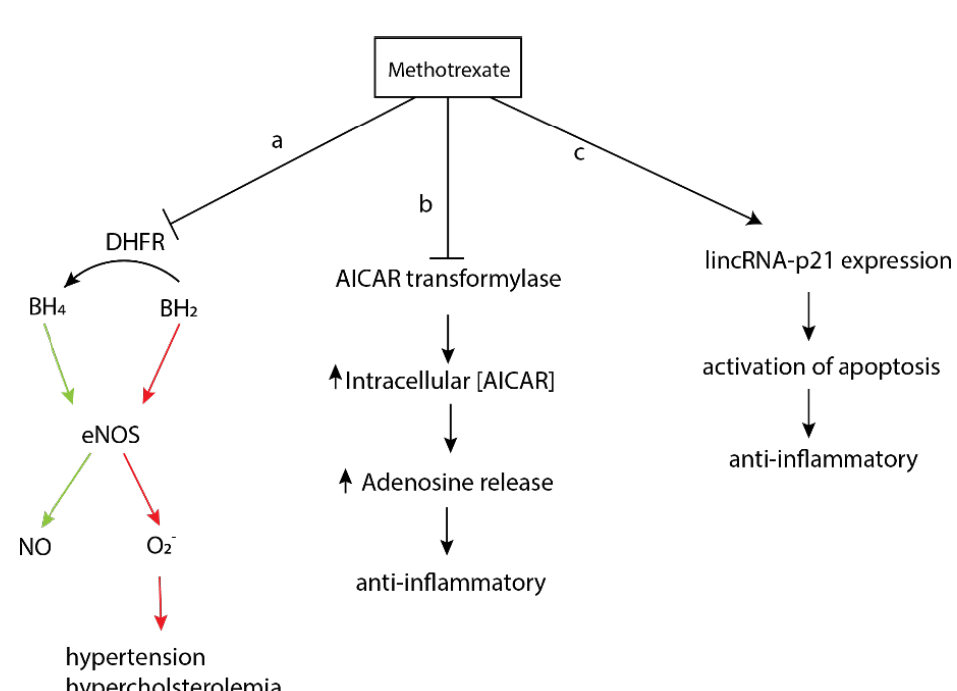
Figure 3. Metabolic pathways of methotrexate. ( a ) Methotrexate inhibits dihydrofolate reductase (DHFR) and prevents conversion of dihydrobiopterin (BH 2 ) to tetrahydrobiopterin (BH 4 ), leading to uncoupling of NO synthase. ( b ) Methotrexate inhibits AICAR transformylase, leading to increased adenosine levels and subsequent anti-inflammatory responses. ( c ) Methotrexate stimulates lincRNA-p21 expression, leading to increased apoptotic gene expression and subsequent anti-inflammatory responses.